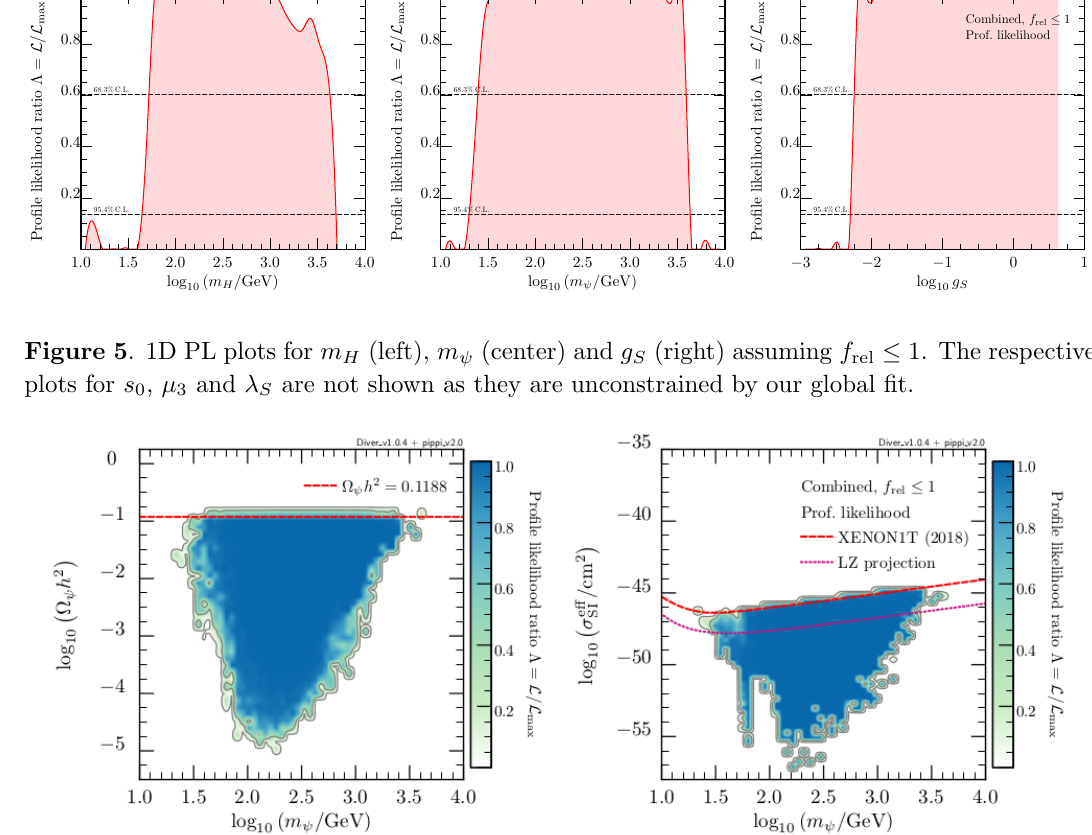
Figure 6 . Left panel : fermion DM relic density vs. the fermion DM mass. The red dashed curve corresponds to the Planck measured value [67]. Right panel : e(cid:11)ective SI DM-nucleon cross-section vs. the fermion DM mass. The red dashed curve shows the current 90% C.L. upper limit from the XENON1T (2018) [68], whereas the violet dotted curve shows the projected sensitivity of the LUX-ZEPLIN (LZ) [122]